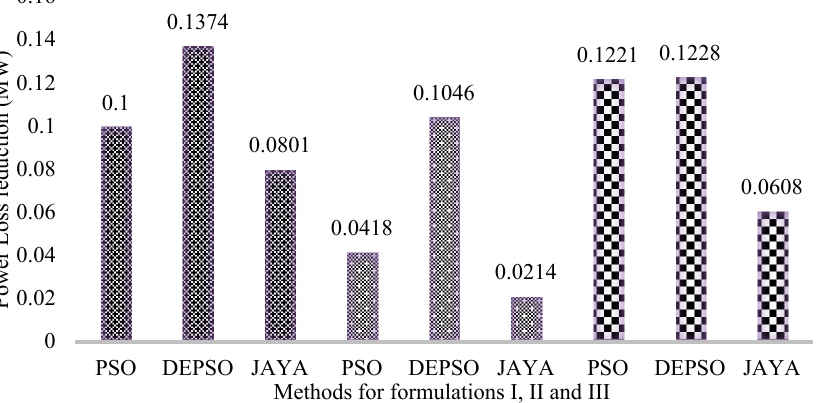
Figure 2. Power loss reduction for IEEE 14-bus system.